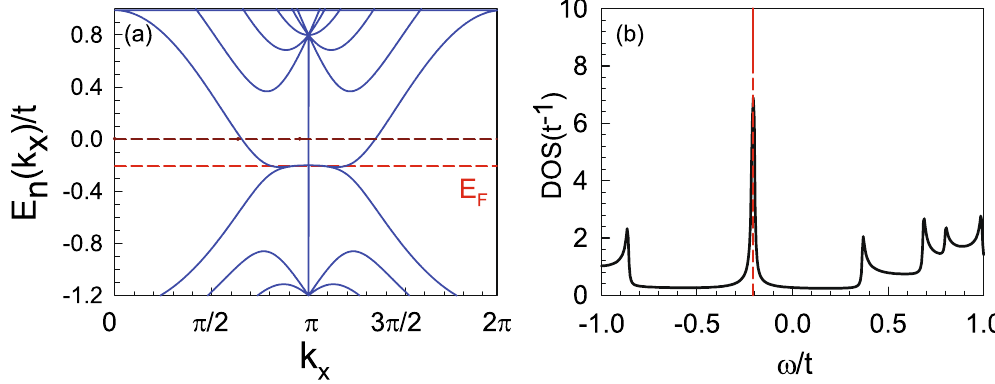
Figure 3. Band structure ( a ) and DOS ( b ) of a six-chain nanoribbon system. Note that the flat band bottom, located at approximately − 0.2 t in ( a ), leads to the DOS peak in ( b ). The Fermi level of the half-filled system is marked by the red dashed lines in both figures.